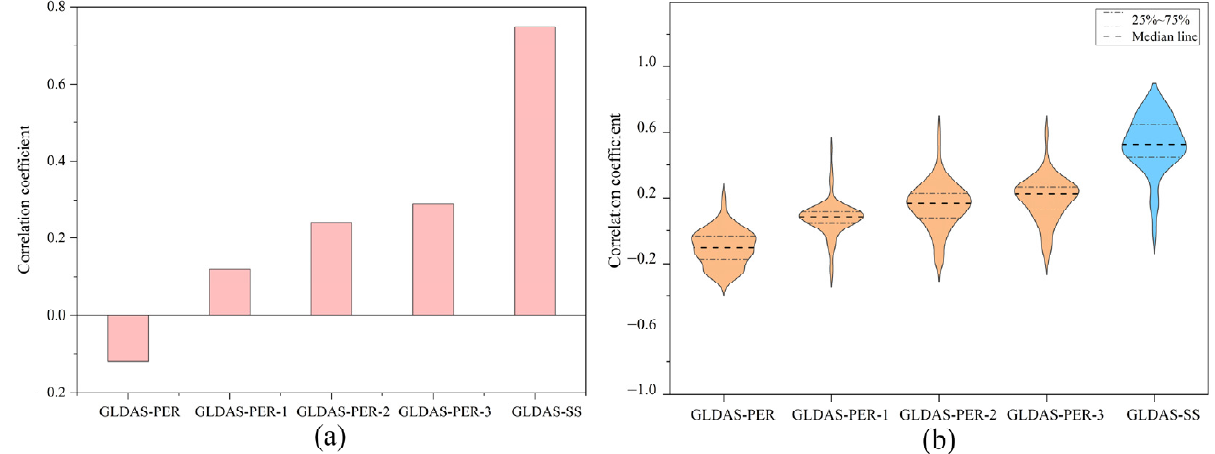
Figure 10. Time-lag effect of TWSC ( a ) and range of correlation coefficients ( b ) estimated by the PER method based on GLDAS. GLDAS-PER represents the correlation coefficient between TWSC estimated by the PER method based on GLDAS and results from GRACE; GLDAS-PER-1 represents the correlation coefficient between TWSC estimated by the PER method based on GLDAS with a lag of 1 month and results from GRACE; GLDAS-PER-2 represents the correlation coefficient between TWSC estimated by the PER method based on GLDAS with a lag of 2 months and results from GRACE; GLDAS-PER-3 represents the correlation coefficient between TWSC estimated by the PER method based on GLDAS with a lag of 3 months and results from GRACE; GLDAS-SS represents the correlation coefficient between TWSC estimated by the SS method based on GLDAS and results from GRACE.